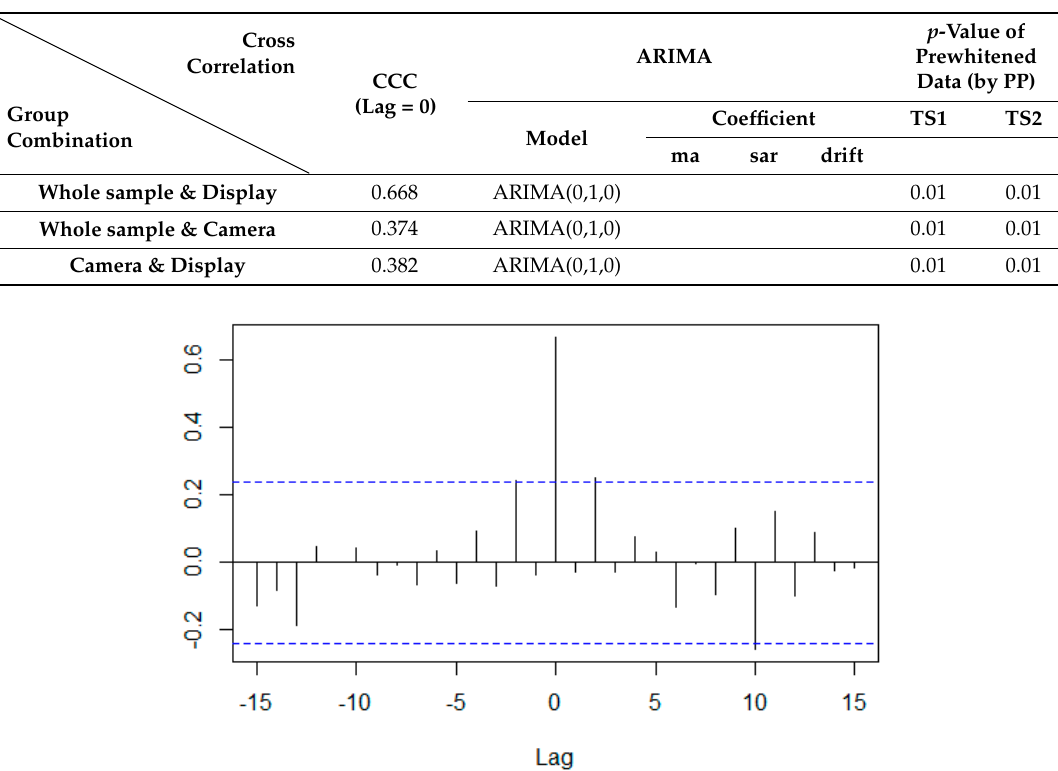
Figure 17. Average BHAR for Jan 2013–Jul 2018. Table 6. Cross-correlation of average BHARs for Jan 2013–Jul 2018.